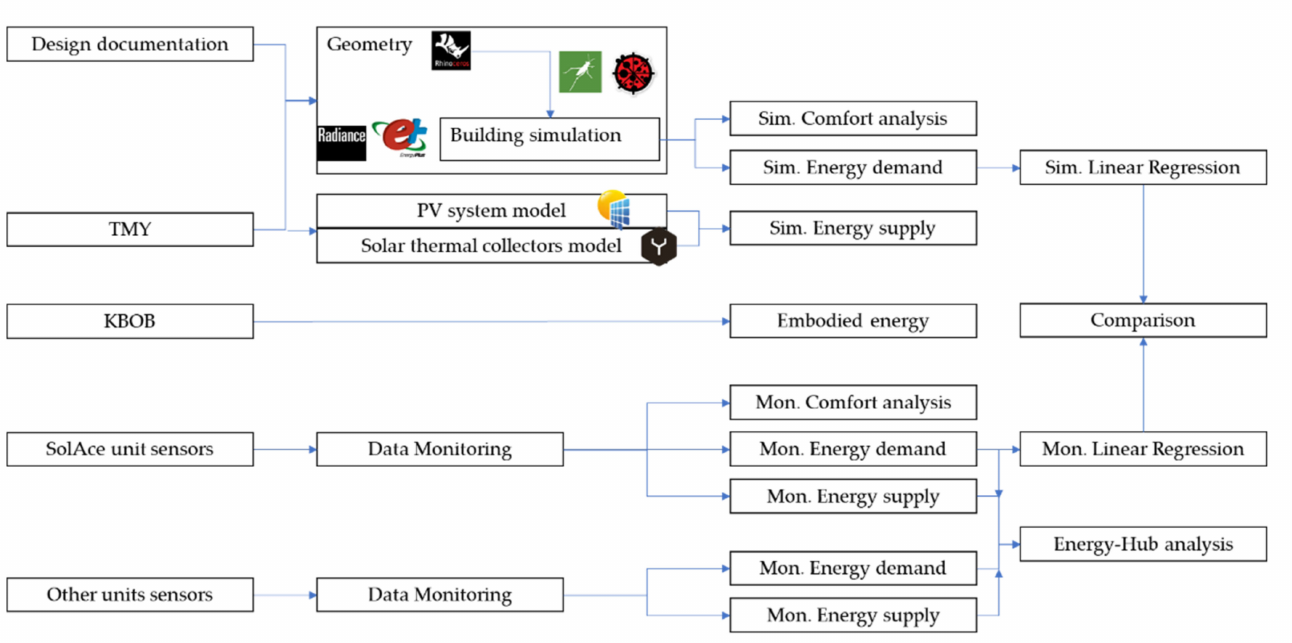
Figure 1. Overall methodology